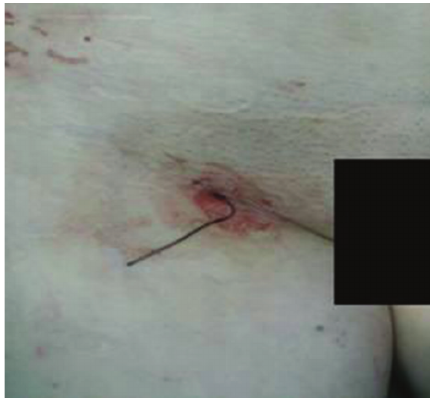
Figure 1: Pseudoaneurysm with puss discharge.